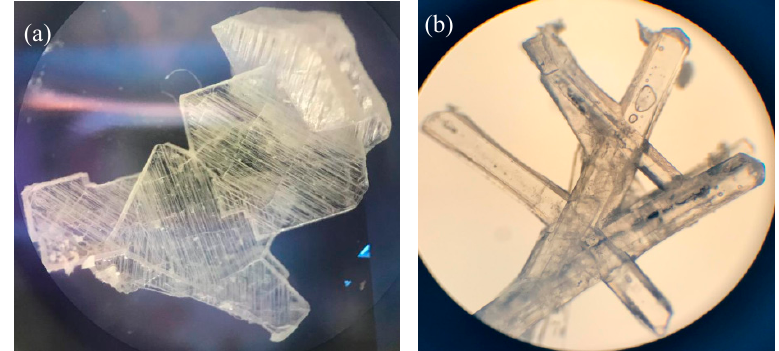
Figure 9. Crystal of the new diclofenac–sodium–proline–monohydrate ( a ) compared to NDPT ( b ) under a binocular microscope observation (100 × ).